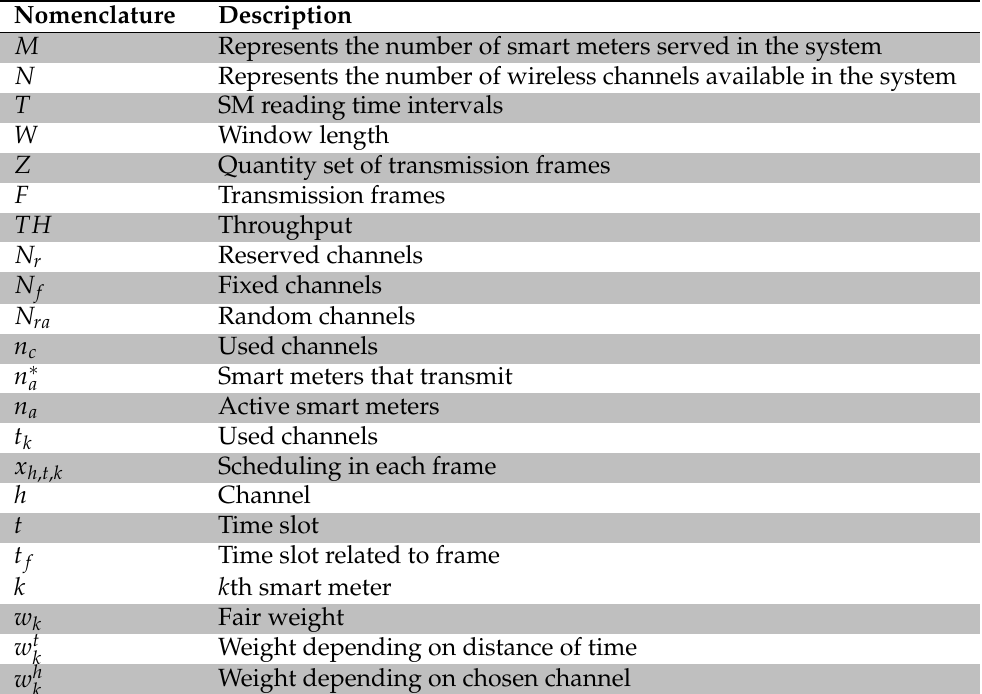
Figure 2. Channel allocation for smart drinking water, gas, and electricity metering. Table 2 describes the variables used in the mathematical model and algorithm. Table 2. Notations used in this